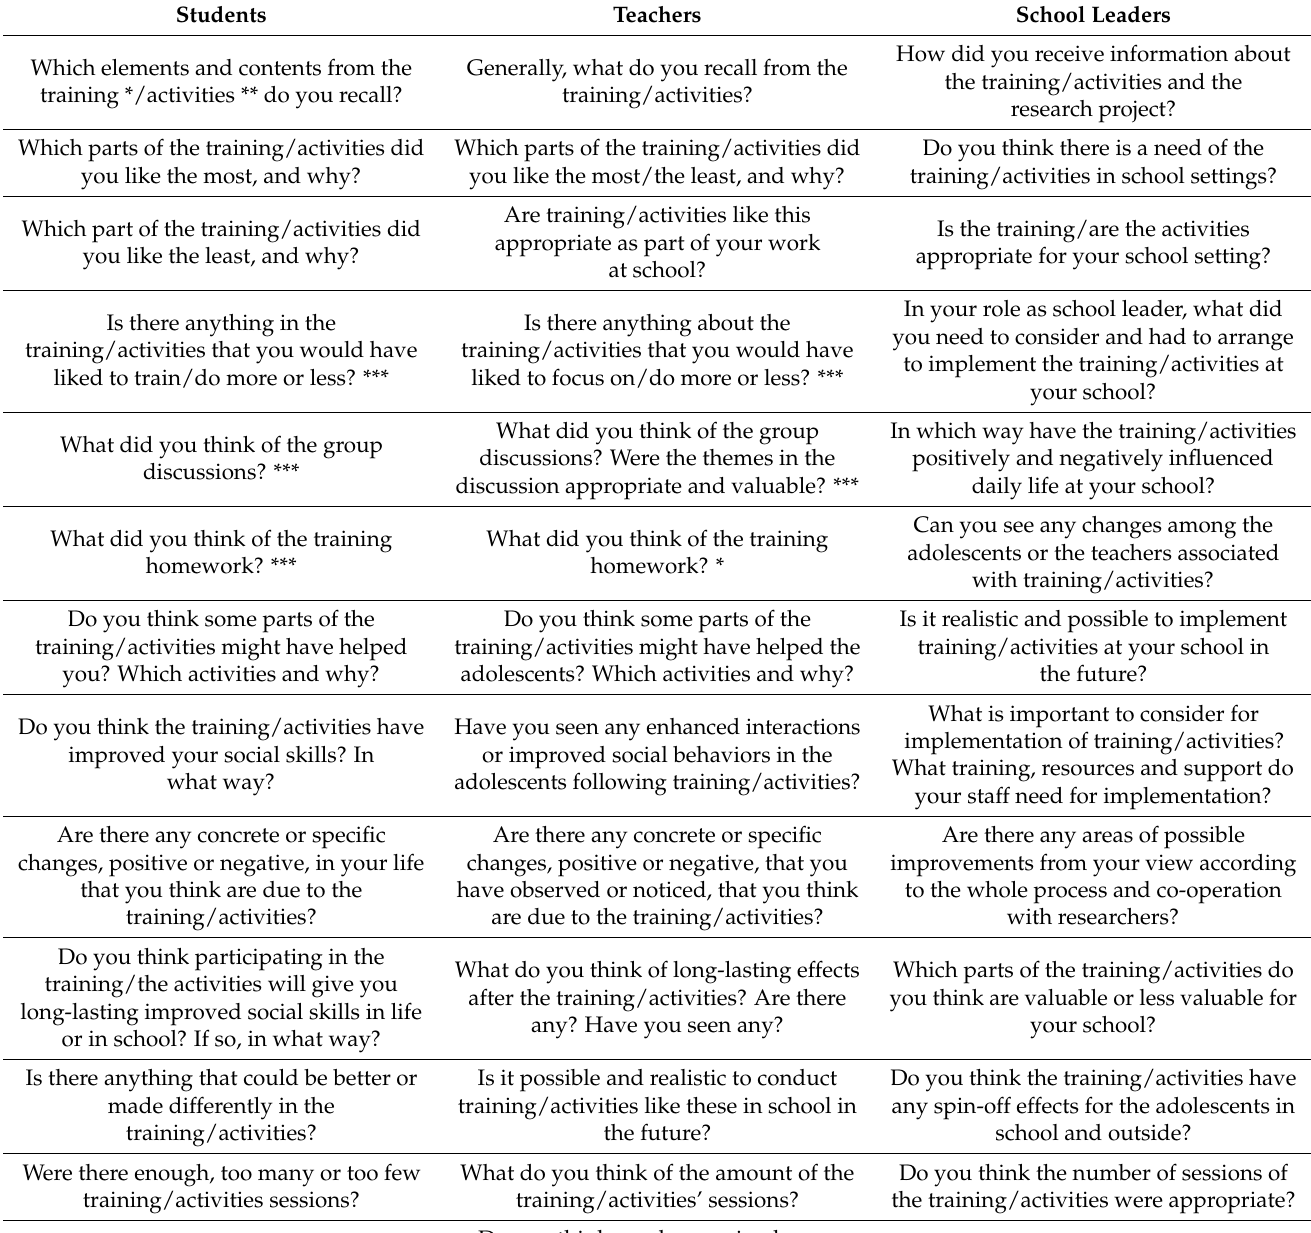
Table 3. Interview guides by the respondent